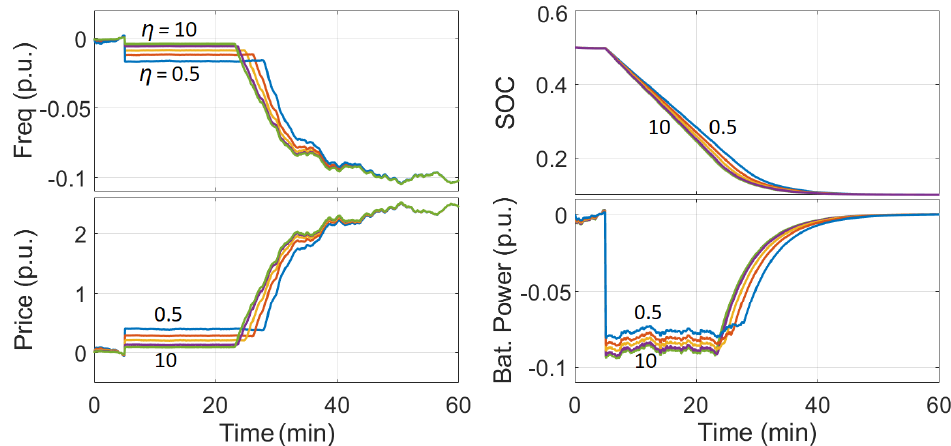
Figure 17. Transactive frequency control using battery system only, for the case of 10% step increase in load and for 𝜂 values of 0.5, 1, 2, 5, and 10.